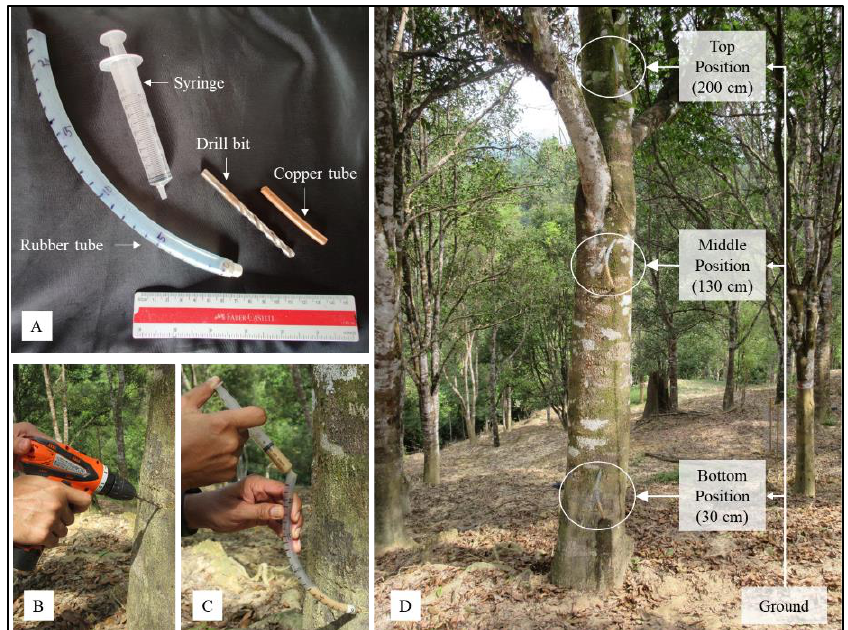
Figure 2. Conducting of the Inoculation Treatment on Aquilaria malaccensis Lam., Tree by: ( A ) Inoculation Accessories, ( B ) Drilling Angle, ( C ) Inoculant Dripping, and ( D ) Inoculation Positions . Table 2. Inoculation Treatments with Selective Diameter Classes, Inoculation Positions, Inoculation Types, and Replication in Standing A. malaccensis Trees .